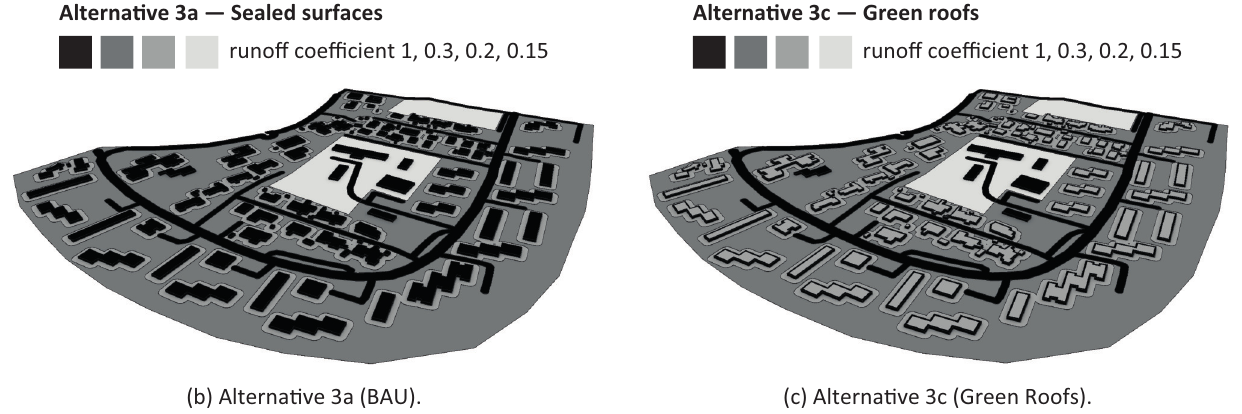
Figure 6. Total rainwater runoff for design scenarios and variants in project area (a) and exemplary graphic display of IP of sealed and unsealed areas of Alternative 3 as BAU (b) or with green roofs